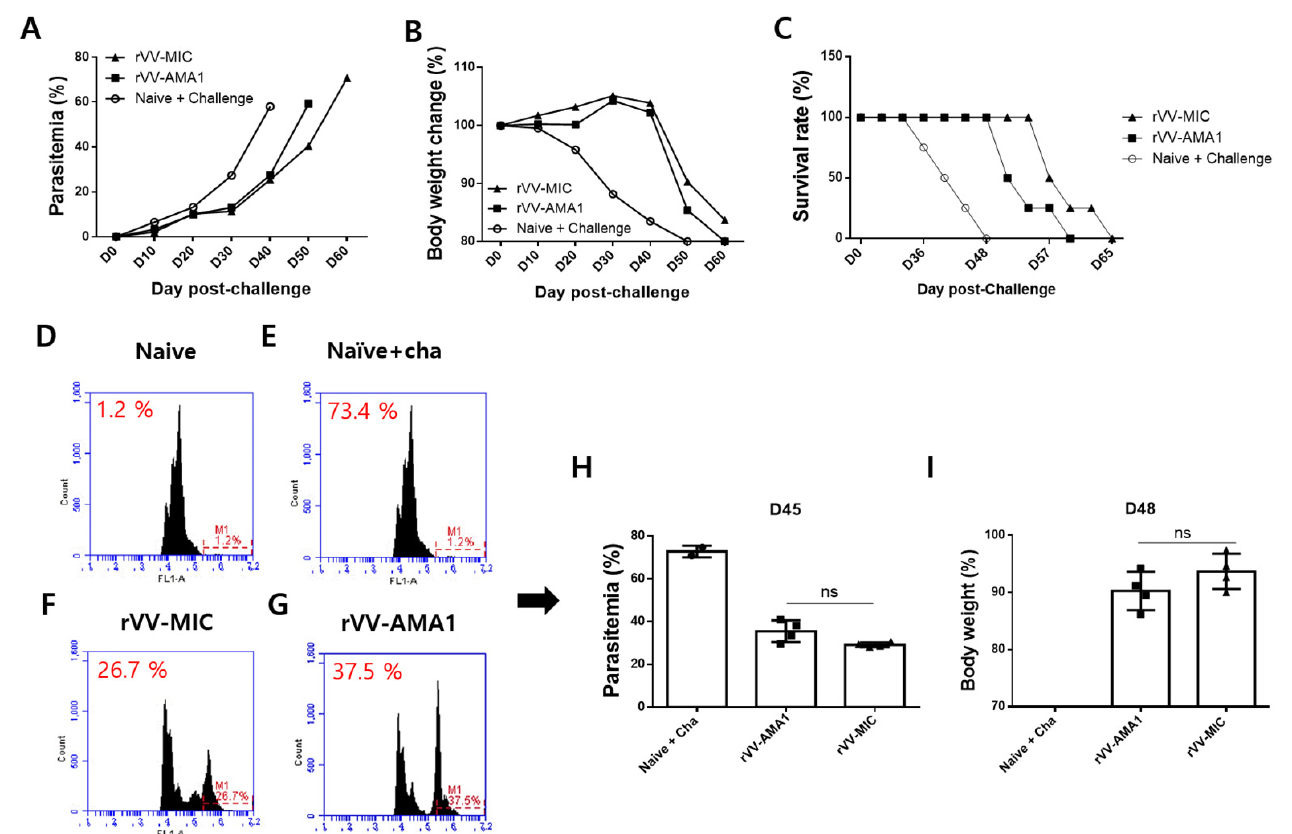
Figure 6. Parasitemia, body weight, and survival rate. After immunization with the rVV-AMA1 or rVV-MIC vaccines, mice ( n = 8) were infected intraperitoneally with 0.05% of P. berghei and monitored at regular intervals to assess changes in parasitemia, body weight, and survival. Parasitemia ( A ), body weight changes ( B ), and survival rate ( C ) from days 0 to 65 post-challenge infections have been monitored. The highest differences in parasitemia ( D – H ) and body weight ( I ) between immunized mice and non-immunized naïve control were observed at days 45 and 48 post-challenge infections, respectively. ns: no statistical